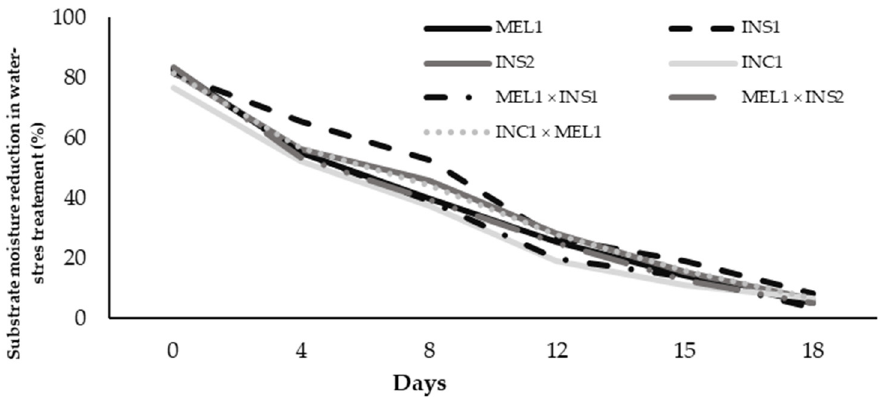
Figure 1. Reduction of substrate moisture in the water stress treatment measured by a WET-2 sensor in Solanum melongena (MEL1), S. insanum (INS1 and INS2), S. incanum (INS1) and their hybrids (MEL1 × INS1, MEL1 × INS2 and INC1 × MEL1). Each plotted value is the mean of the water content of five pots; each of these values, in turn, is the average of three independent measurements per pot.